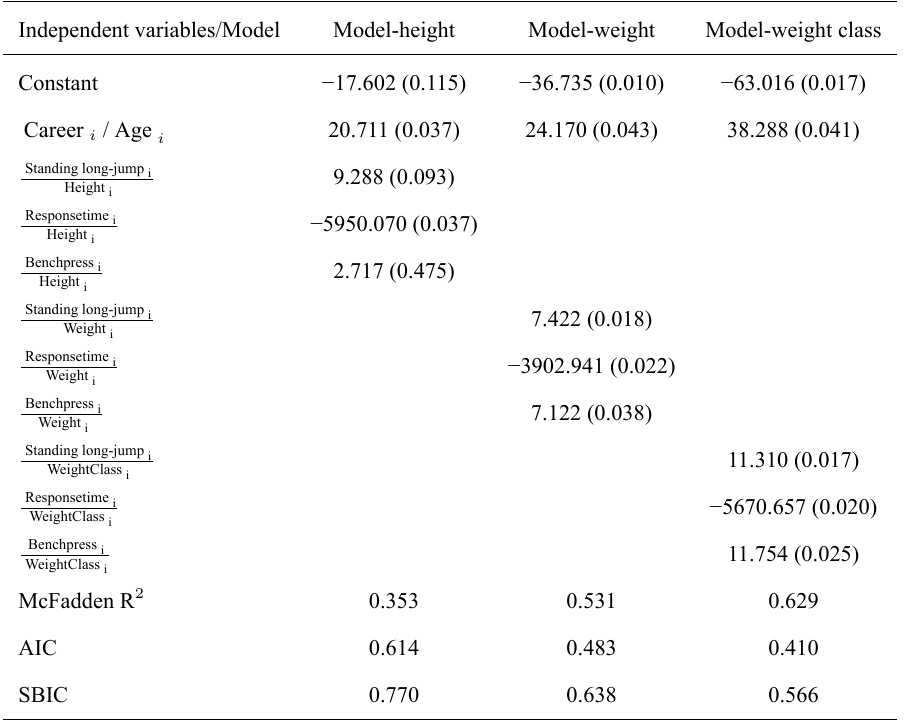
Table 4. Logit model estimation results. The maximum likelihood estimation (MLE) method was used to estimate the logit model; additionally, E-views9.5 was used as a statistical software. The values in brackets in the following table are p